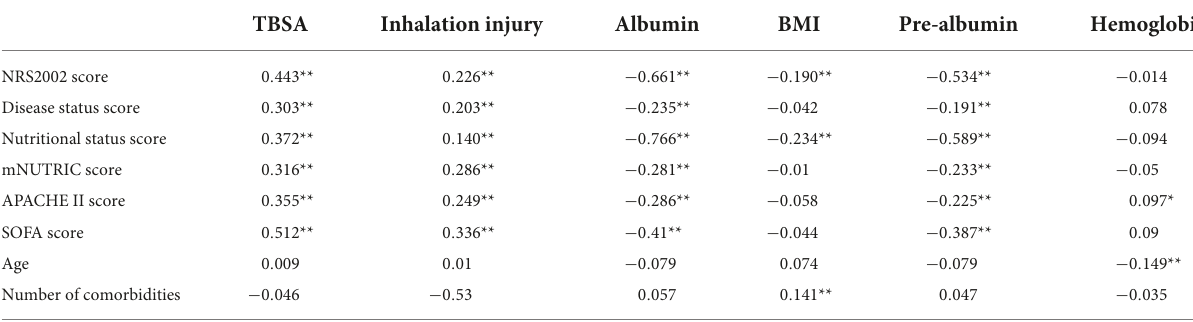
TABLE 3 Correlations of the NRS2002 and mNUTRIC to clinical characteristics and nutritional indicators. TBSA Inhalation injury Albumin BMI Pre-albumin